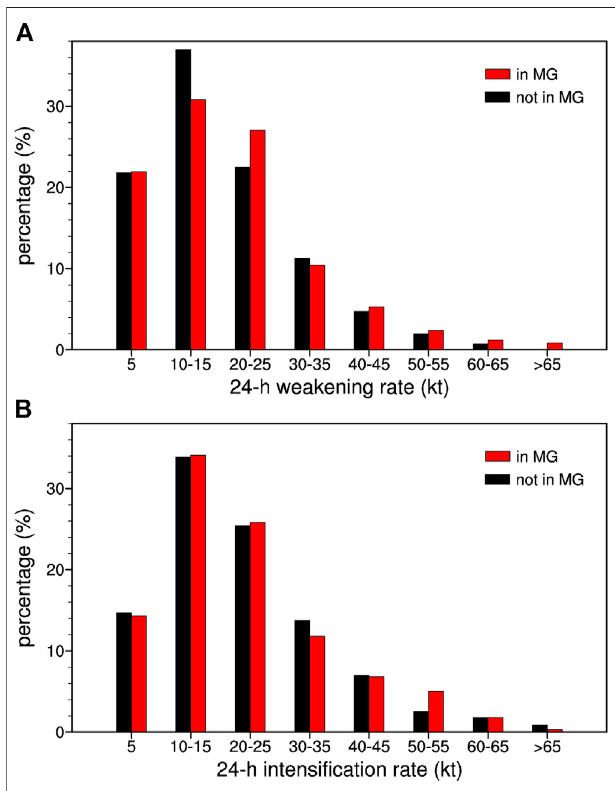
FIGURE 5 | (A) The percentage of over-water 24-h weakening rate and (B) the percentage of over-water 24-h intensi fi cation rate. Events in and not in MGs are denoted by red bars and black bars, respectively. The horizontal coordinate is the 24-h intensity change of TCs (knot).